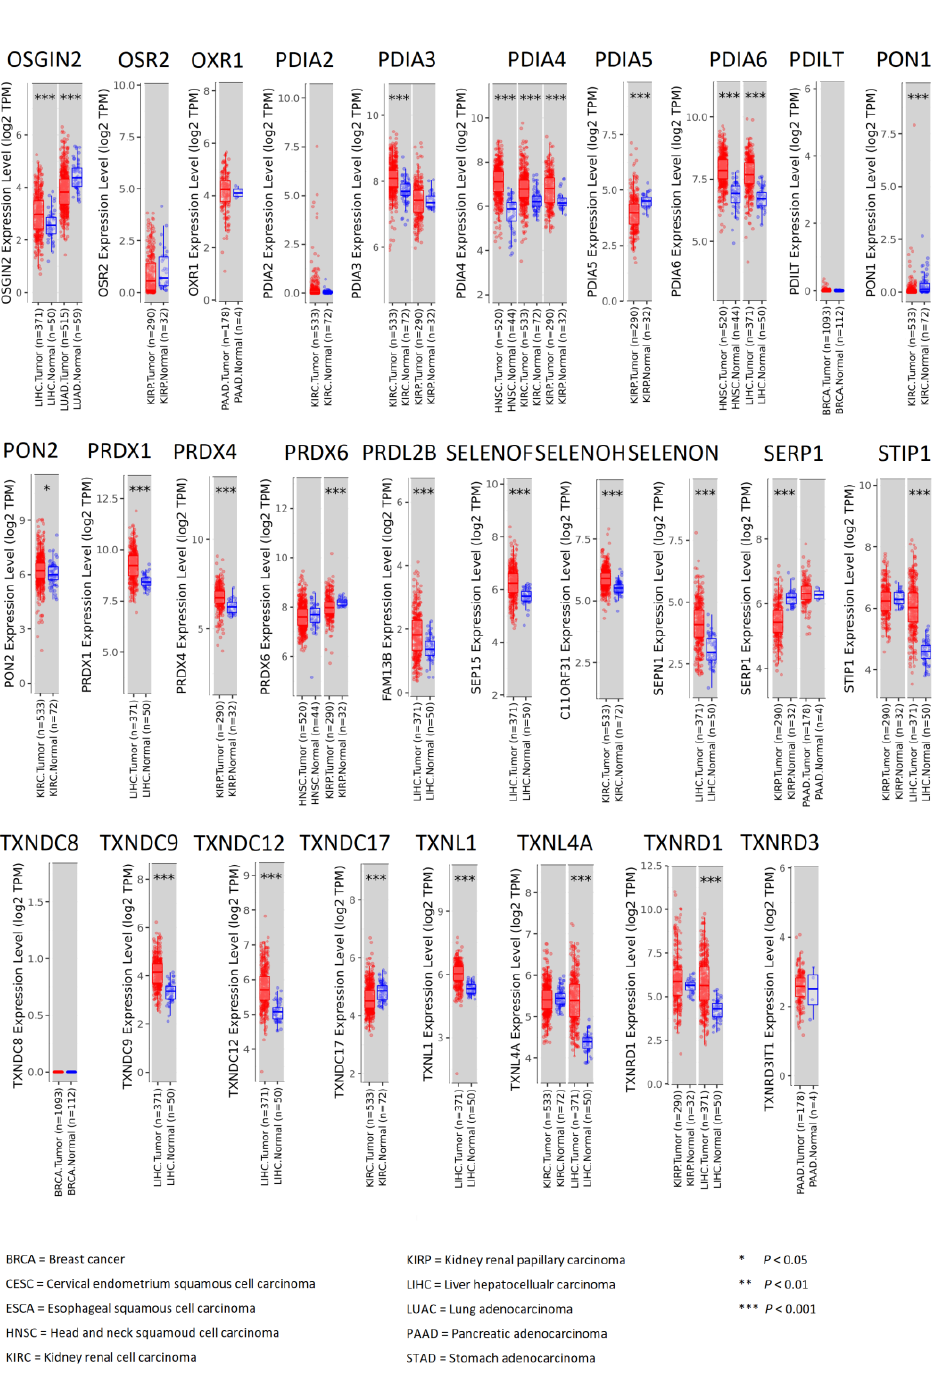
Figure 4. Comparative expression of 71 genes in tumors and corresponding normal tissues (part 1). Comparative expression of 71 genes in tumors and corresponding normal tissues (part 2). In summary, we further downscaled the number of genes of interest to 17.